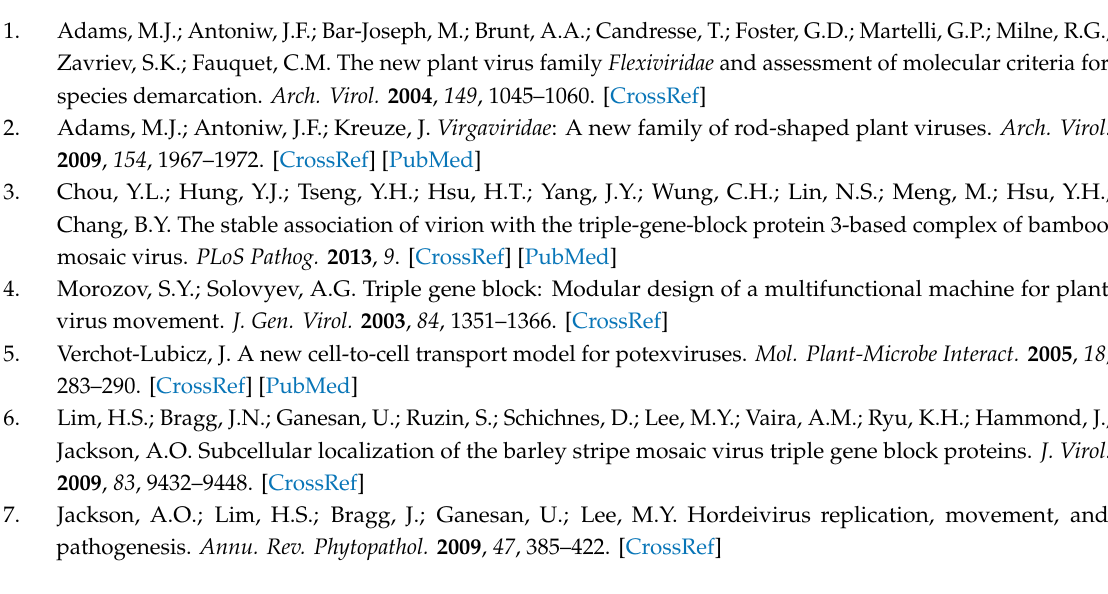
to construct entry vectors for BiFC experiments. Table S3: Primers used to construct vectors for subcellular localization experiments and for the identification of local RNA silencing suppressors. Table S4: Primers used to construct vectors for the identification of systemic RNA silencing suppressors. Table S5: Nucleotide and amino acid sequence similarities of the cDNAs of open reading frame (ORF) 2–6 between CYVCV-HB and isolates available in